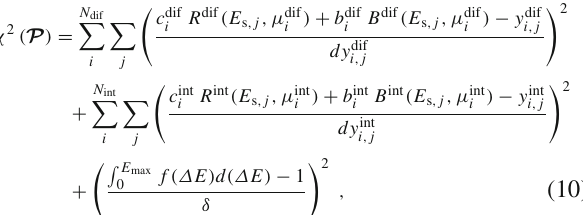
Fig. 10 Results of the combined fit to the differential and integral datasets at different column densities. Each panel shows the data points (blue) and the best-fit result (red) in the upper part and the correspond- ing residuals in the lower part. A normalization is applied to each of